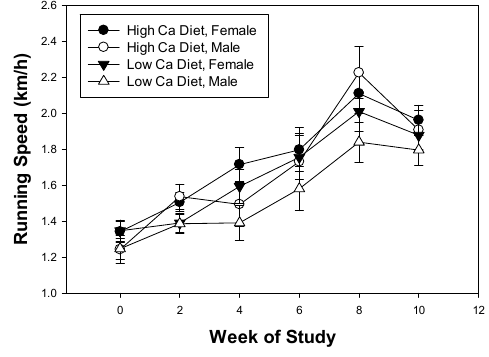
Figure 2. Mean (± SE) running speed of least shrews maintained on mealworm diets with different calcium